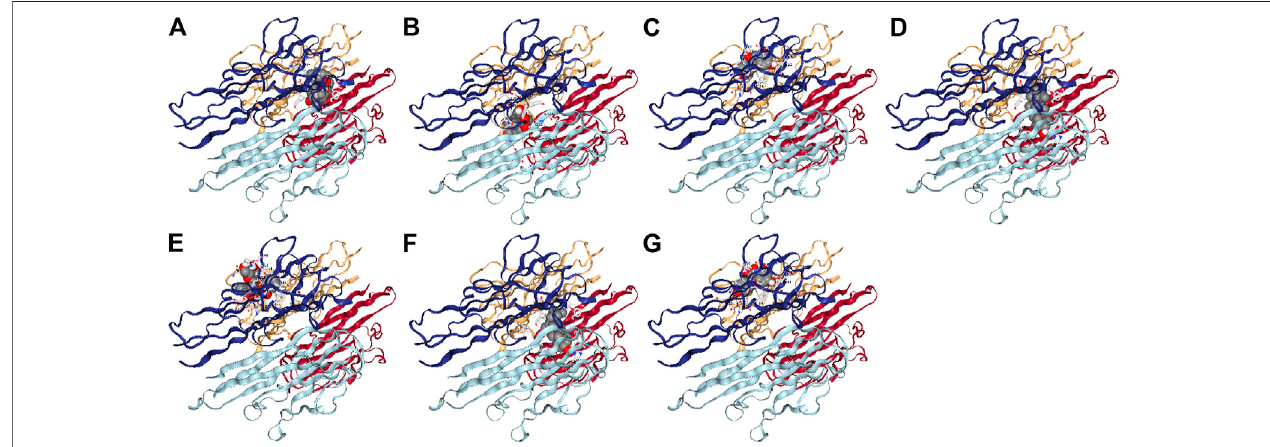
FIGURE 7 | The 3D map of the binding of mairin. (A) DPHCD, (B) (+)-catechin, (C) beta-sitosterol, (D) paeoni fl orin, (E) sitosterol, (F) kaempferol, and (G) with TNF- α